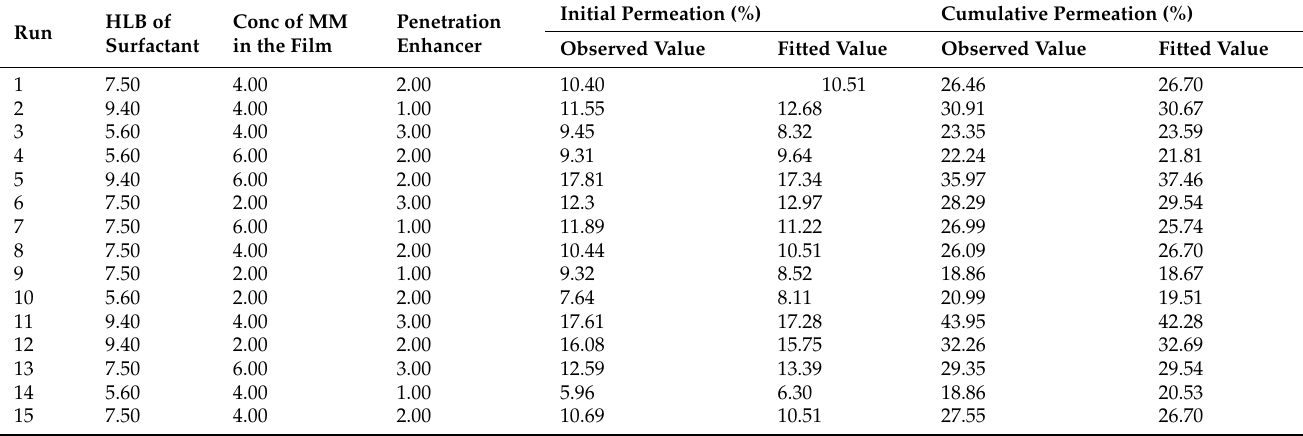
Table 2. Experimental matrix of AVA-MM-loaded transdermal film as suggested by the Box–Behnken design, with the observed and the fitted values of the responses (Y 1 and Y 2